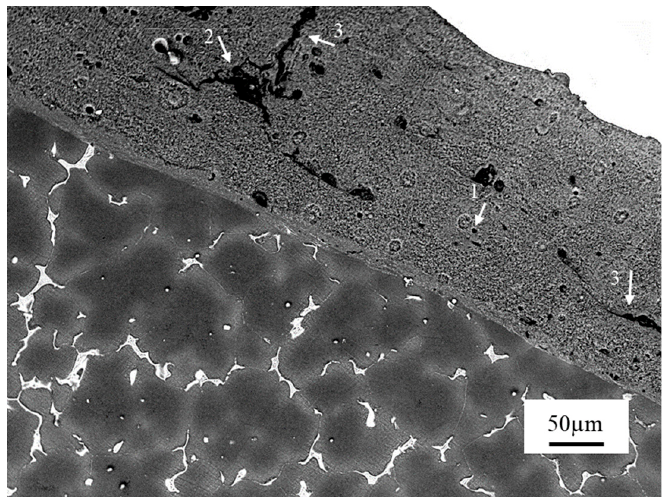
Figure 8. SEM micrograph showing the typical voids of the ESD coating: small spherical voids (n°1), large, random shaped voids (n°2) and laminar porosity (n°3).